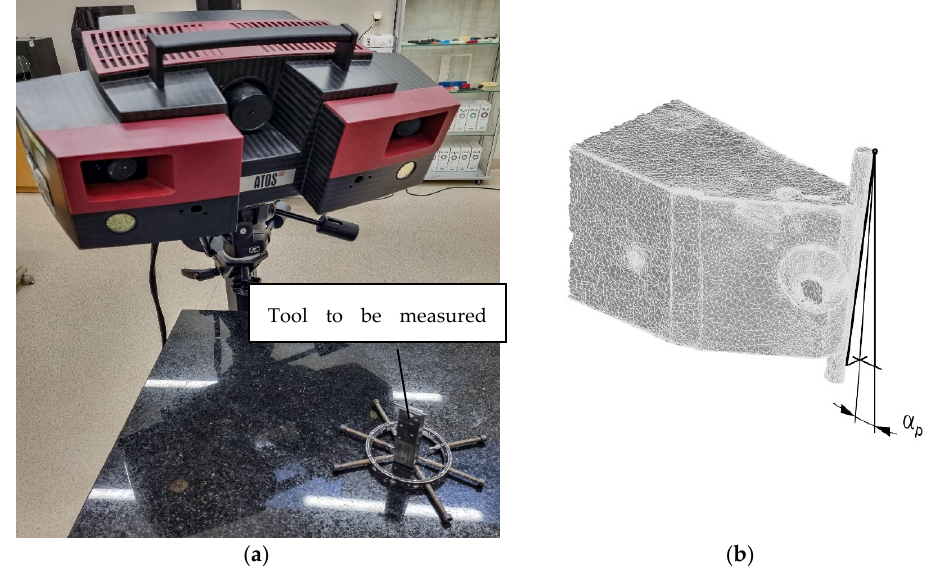
Tool to be measured